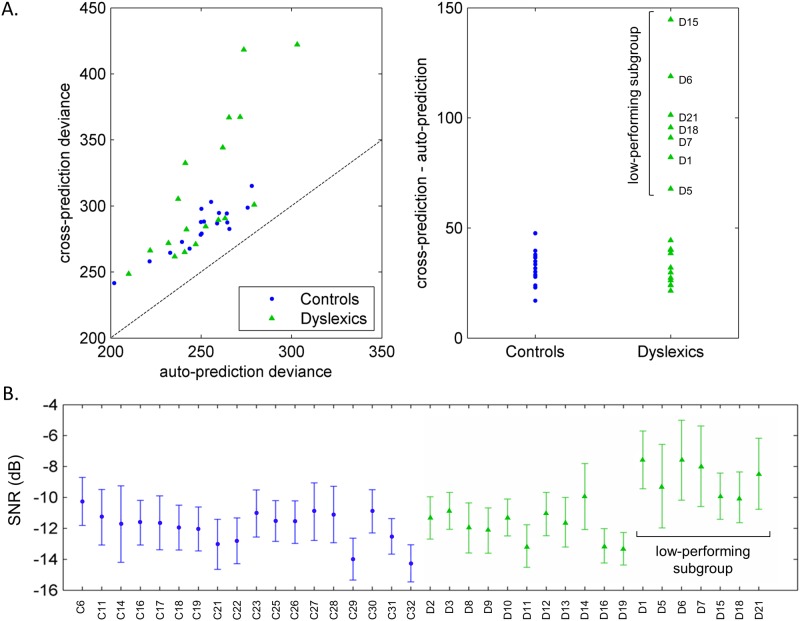
Individual strategies and performances in the task.A. Auto- and cross-predictions for all participants. Left panel: cross-prediction deviance as a function of auto-prediction deviance. The dotted line indicates the cross-prediction = auto-prediction line. Right panel: difference between cross- and auto-prediction deviances for the two groups. B. SNR threshold and confidence intervals for each listener. From these two representations, 7 dyslexics clearly stand out as a low-performing subgroup.